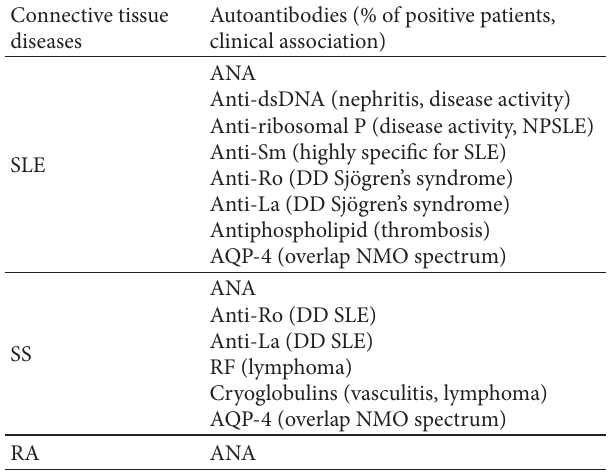
Table 1: Most frequent autoantibodies in nervous system involve- ment in connective tissue diseases SLE, SS, and RA.